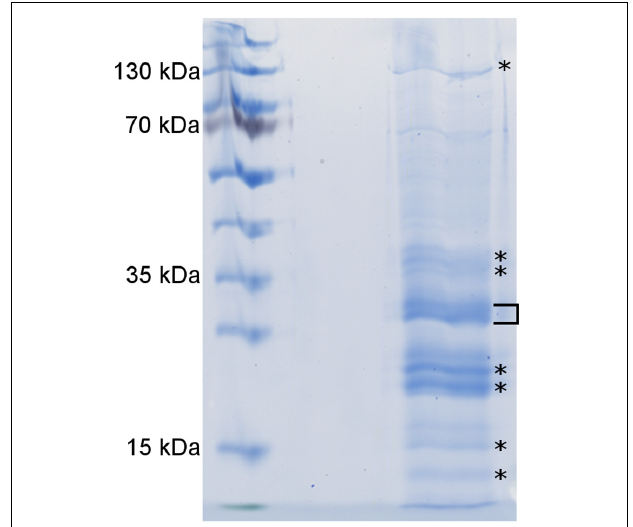
FIGURE 2 | In vivo cross-linking reveals putative interaction partners of CdPpiB. Shown is a representative analytical SDS-PAGE with the elution fraction after the in vivo cross-linking and the subsequent Strep-tag affinity purification of PpiB-StrepII and its putative interaction partners. Bands denoted with an asterisk were cut out analyzed by mass spectrometry. The bracket indicates bands that also occurred in control experiments without cross-linking and were excluded from the analysis.